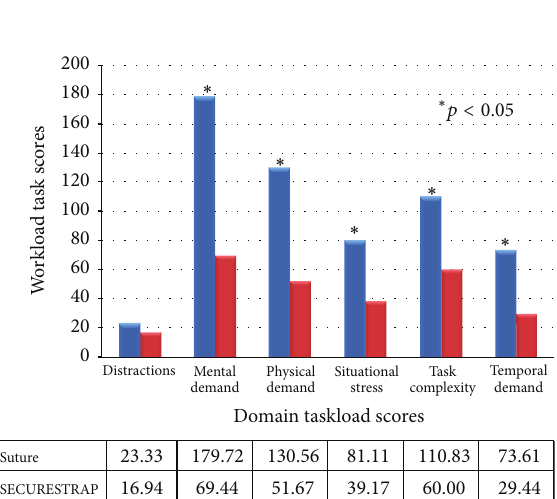
Figure 3: Task load (SURG-TLX) domain scores for suture and mechanical fixation